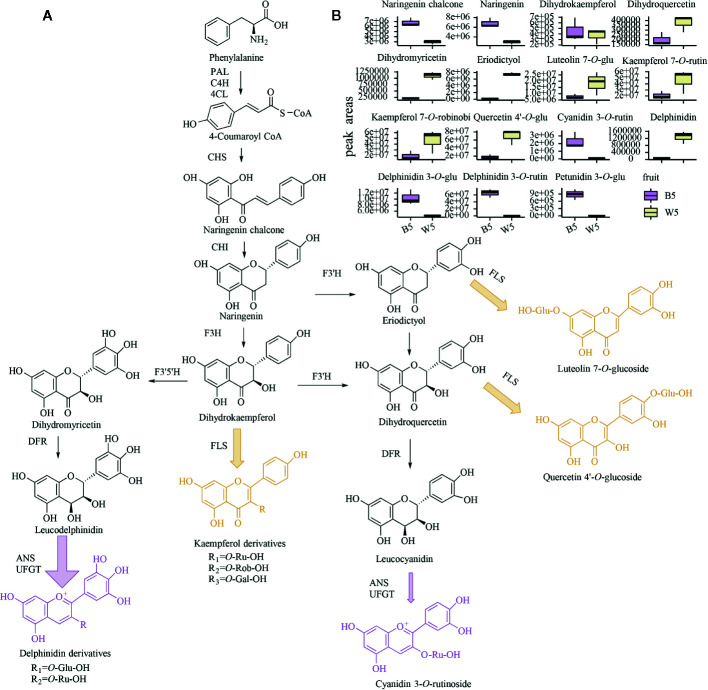
Flavonoid metabolome of two fruits at S5. (A) a diagram of the putative anthocyanin metabolic process in black or white fruits; purple represents the main flavonoid component of black fruit, and yellow represents the main flavonoid substance that metabolizes white berries. (B) Box plots of the relative content of 14 major flavonoids in two fruits; center lines denote medians, bounds of boxes denote first and third quartiles. HPLC analyses were performed on three biological replicates.